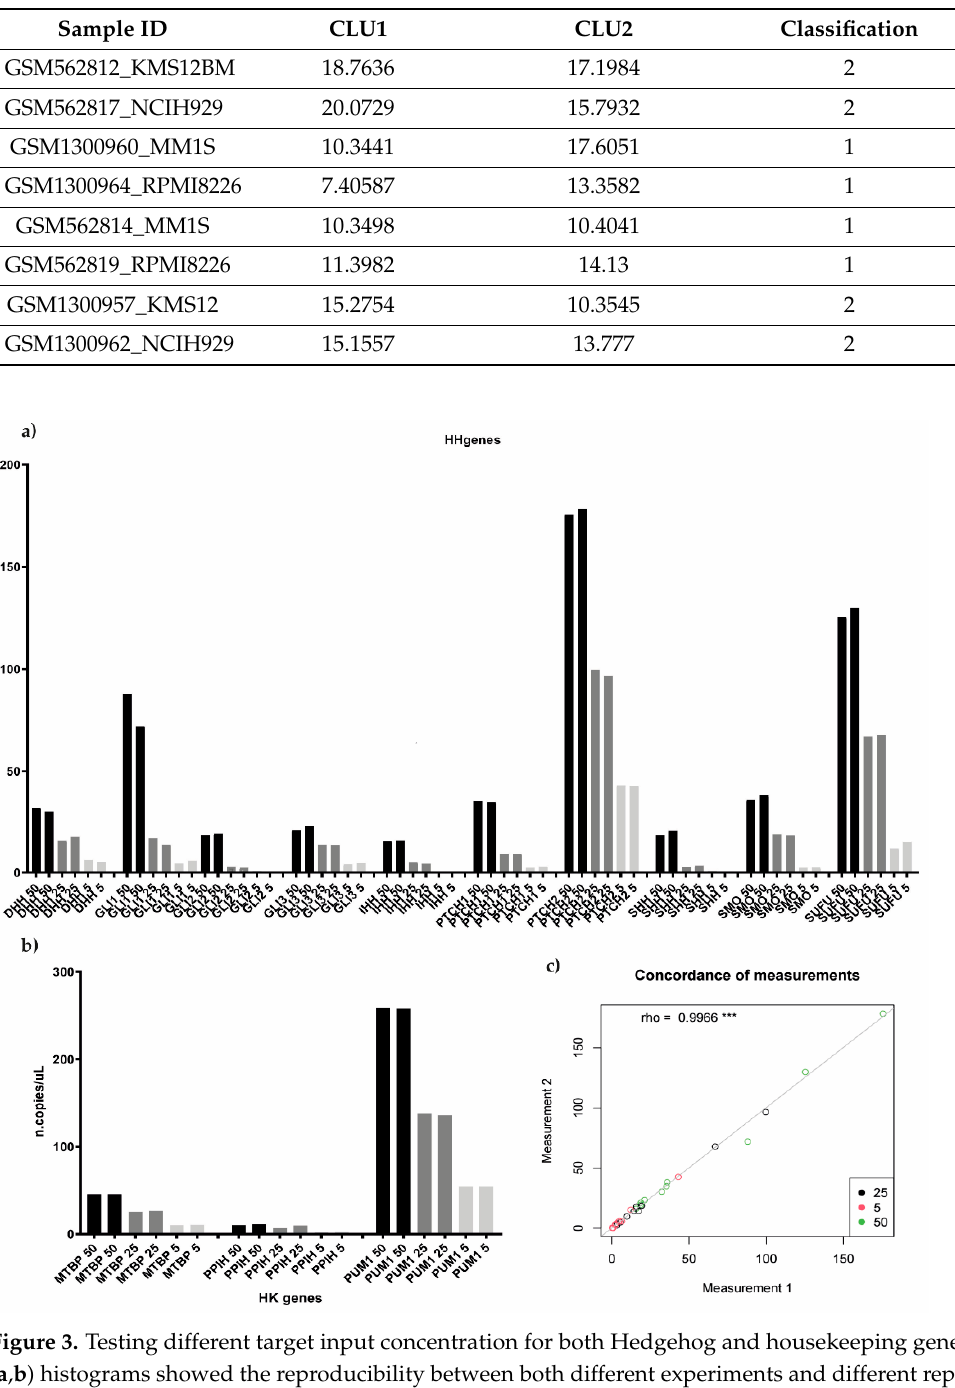
Figure 3 . Testing different target input concentration for both Hedgehog and housekeeping genes.